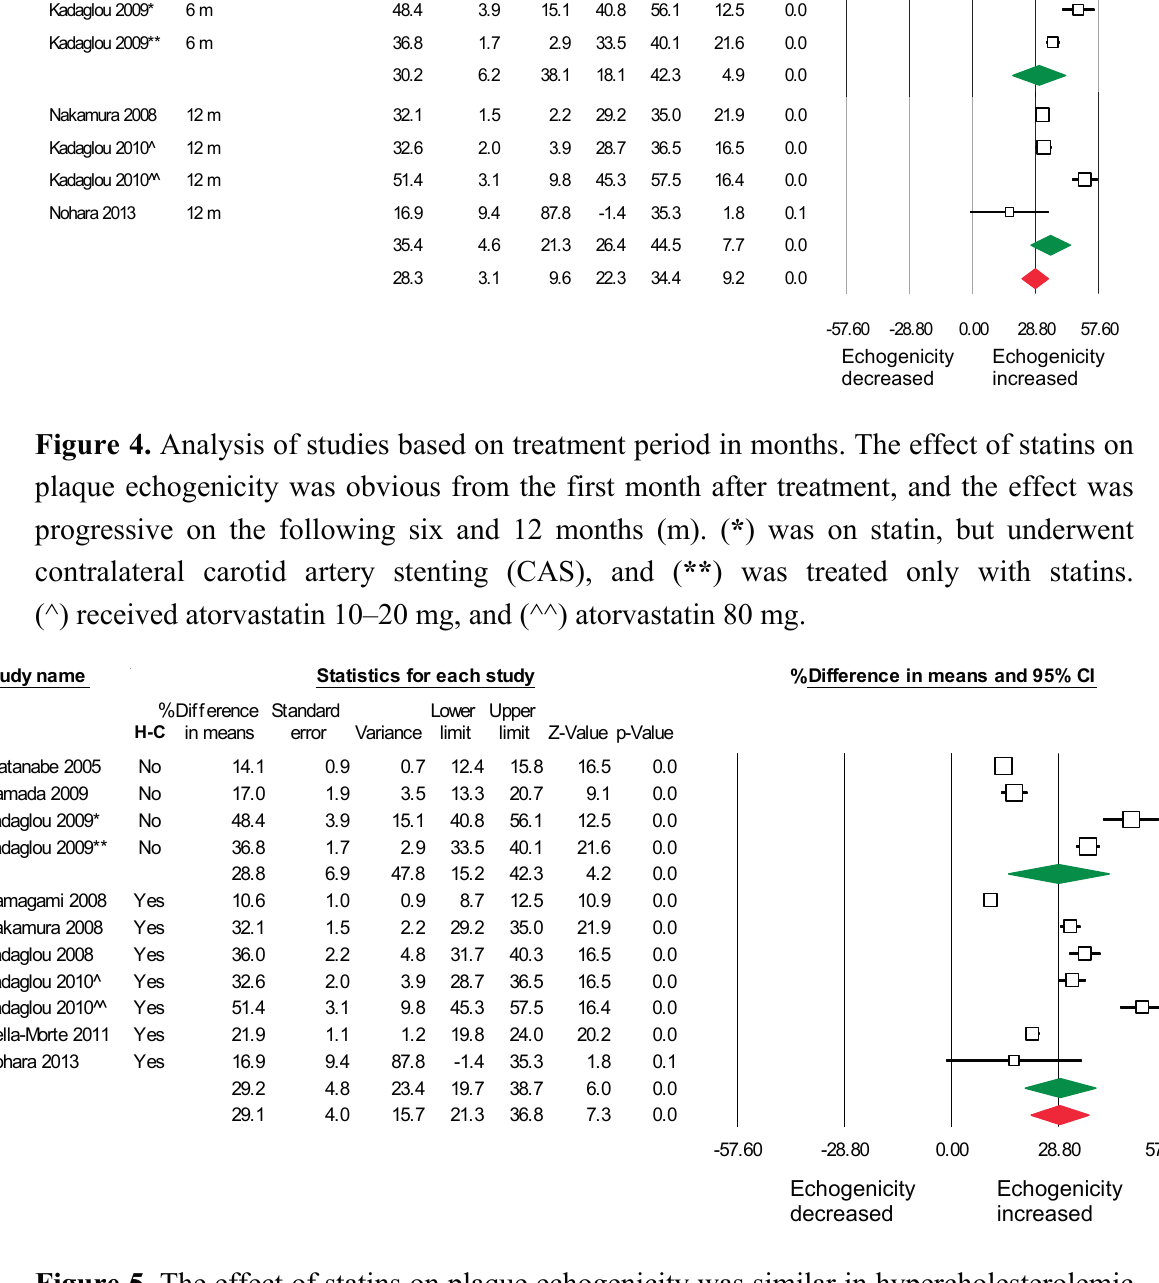
Figure 5. The effect of statins on plaque echogenicity was similar in hypercholesterolemic and non-hypercholesterolemic patients. H–C = hypercholesterolemia at baseline. ( * ) was on statin, but underwent contralateral carotid artery stenting (CAS), and ( ** ) was treated only with statins. (^) received atorvastatin 10–20 mg, and (^^) atorvastatin 80